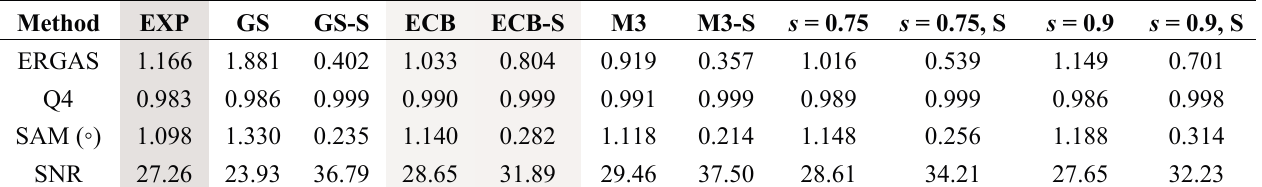
Table 3. Quantitative comparison of the fusion results after degrading the images into the LR resolution, i.e ., at 9.6 m, to check the consistency property of the Wald’s protocol for the QuickBird dataset at the reduced scale.